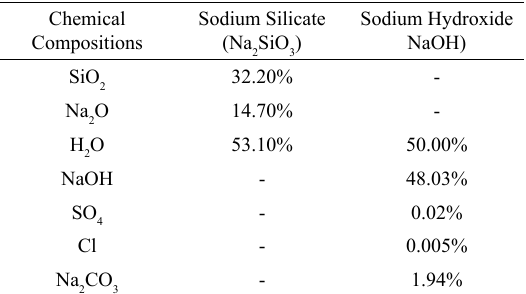
Table 2. Chemical compositions of NaOH and Na